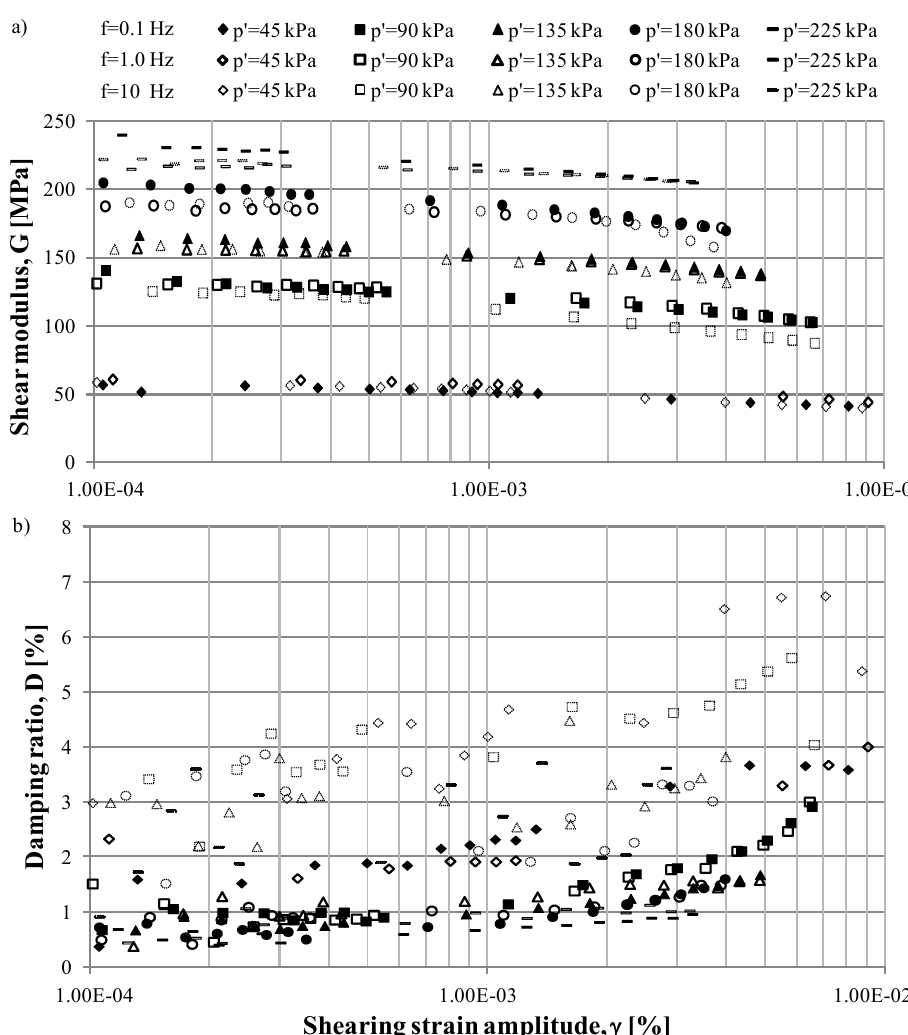
Fig. 8. Shear modulus (a) and damping ratio (b) as a function of shearing strain amplitude for test